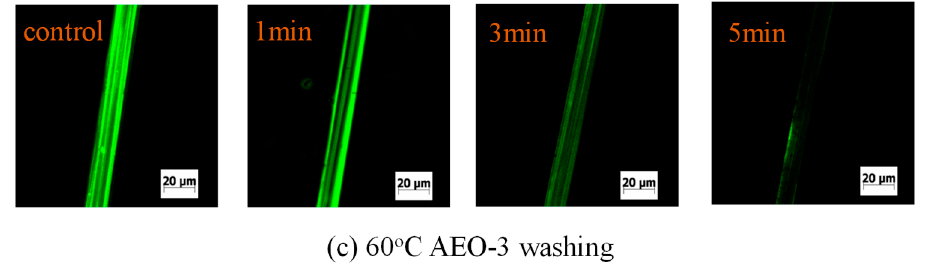
Figure 8. The change of FITC fluorescence intensity on the fiber surface under different washing conditions: ( a ) 25 °C water; ( b ) 60 °C water; ( c ) 60 °C AEO-3 aqueous solution.